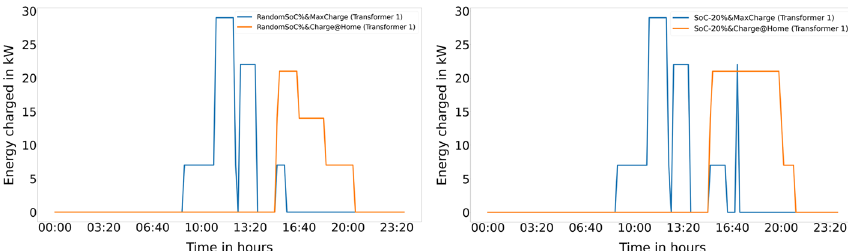
Fig. 14 Power profiles of transformer 1 for the scenario with randomized (left) and 20% (right) SoC, comparing the Charge@Home assumption with the MaxCharge strategy